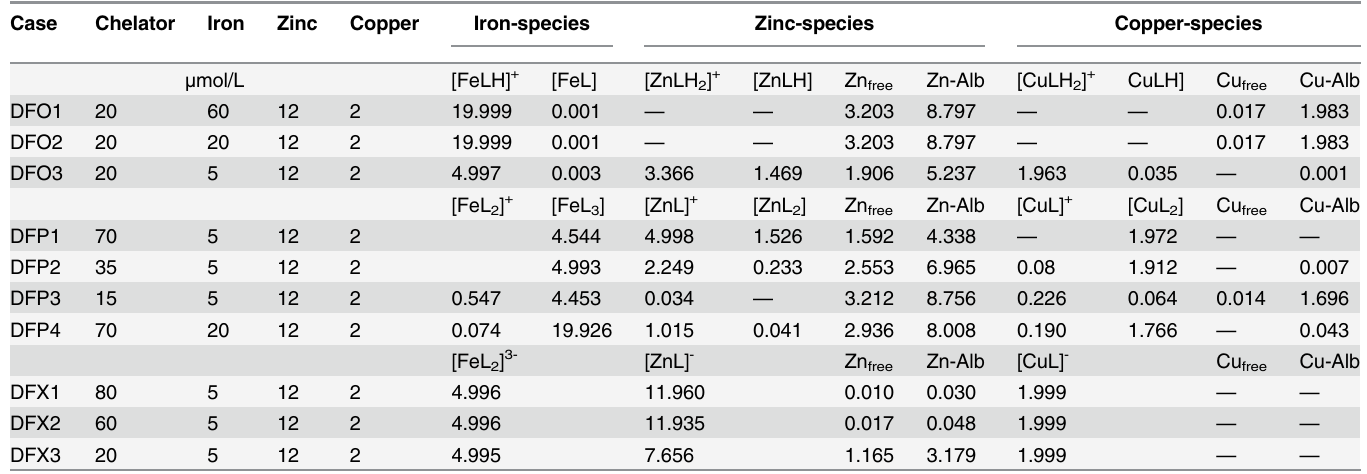
Table 4. Speciation of different simulated conditions in the presence of the three different chelators. Total concentrations of ligands, iron, zinc and copper ( μ mol/L) in species calculations are reported in columns 2 to 5, while the concentrations ( μ mol/L) of calculated complexed species (disregarding minor species) are reported in the remaining